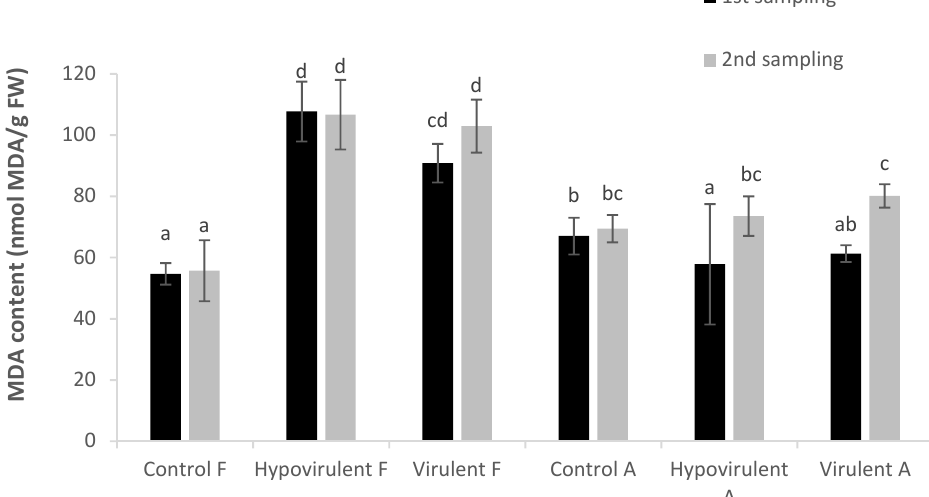
Figure 4. The malondialdehyde (MDA) concentration after infection (21 and 42 days). Values are means ± SD, n = 5. Significant differences among samples based on the Tukey-HSD test. Similar to the data obtained for MDA, the measurements of guaiacol peroxidase (POD) at the first sampling in leaves above the branch (infected with both types of fungi) (Hypovirulent-F, Virulent-F) were statistically higher compared with the other results. How- ever, they also differed statistically from each other and the control (Control-F, Control-A) plants (Figure